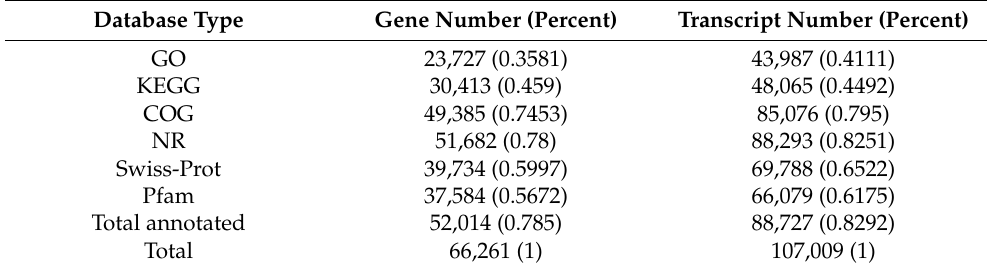
Table 2. The number (percent) of genes successfully annotated to NCBI-NR, Swiss-Prot, Pfam, EggNOG, GO, and KEGG